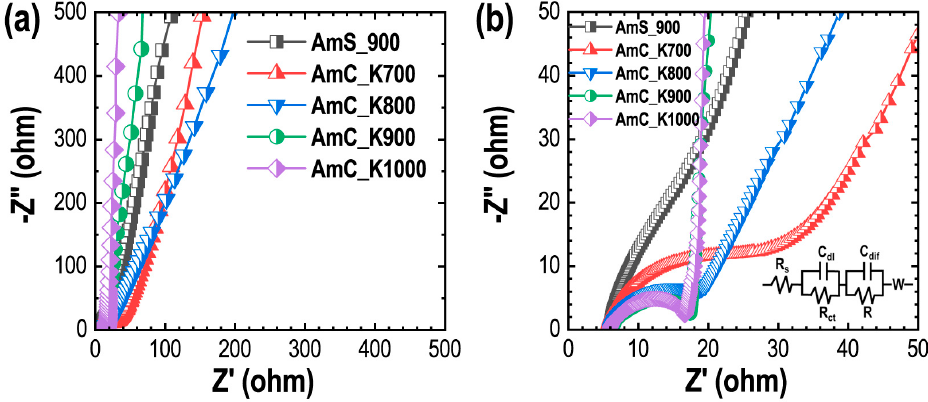
Figure 8. EIS Results: ( a ) Nyquist plots of Amala-seed carbon recorded in an aqueous 1 M H 2 SO 4 solution from low to high frequencies (0.01 Hz to 100 kHz) at an amplitude of 5 mV; ( b ) the corresponding magnified plot. Inset of panel ( b ) representing equivalent circuit diagram, where R s , and R ct represents solution or electrolyte resistance and charge-transfer resistance, respectively. Two capacitance and resistance combinations; C dl , R ct refer to the double-layer formation and C dif , R represent the diffusion contribution. W represents the Warburg diffusion.